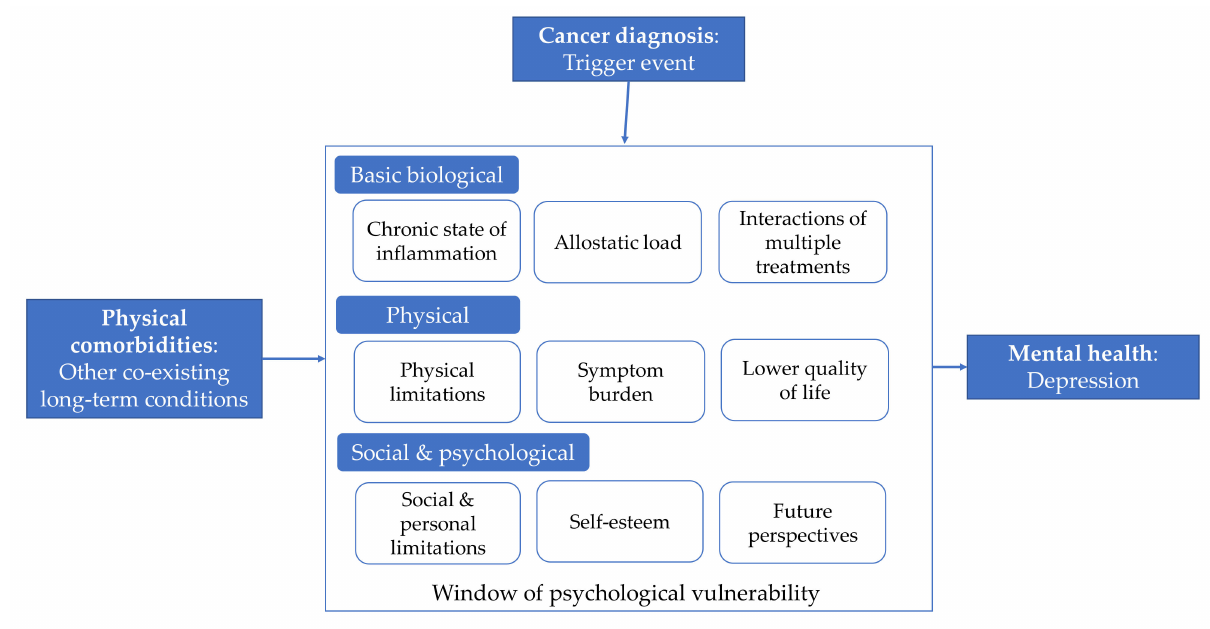
Figure 3. Theoretical model of potential mechanisms through which physical comorbidities could increase the risk of mental health problems such as depression following a cancer